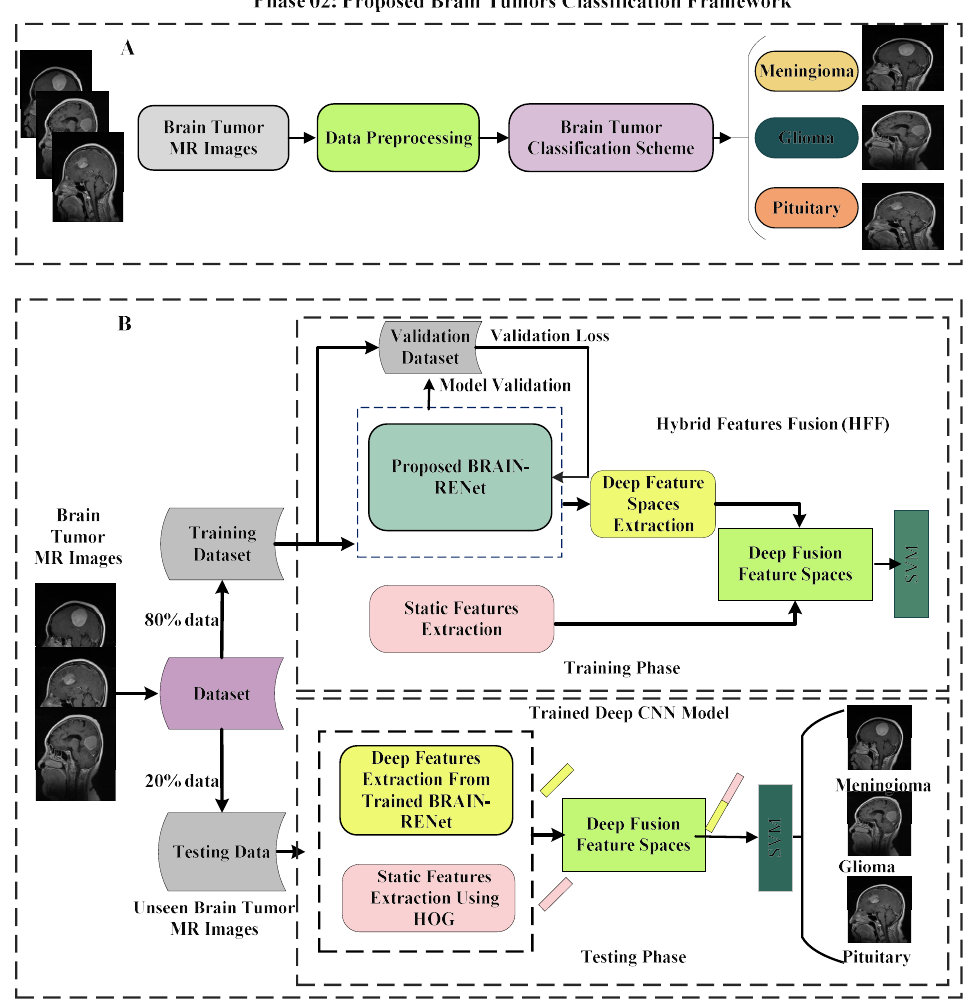
Figure 3. ( A ) Displays the concise details. ( B ) Demonstrates the comprehensive details of the proposed HFF-BTC model.